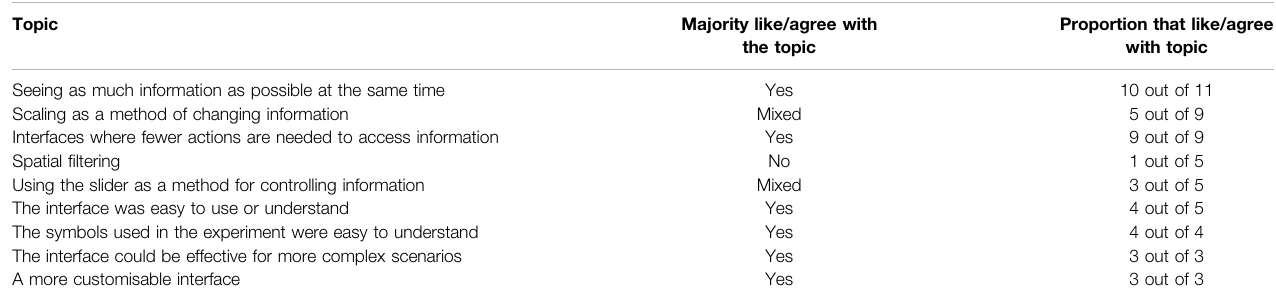
TABLE 1 | Topics that were most commonly talked about in written feedback from participants. Each comment was determined by the authors to be positive or negative aboutasubject.Thenumbersdeterminedtobepositive/negativeareshownhere. Notalltopicswerementionedbyallparticipants, sothetotalnumberofcommentsfor each topic